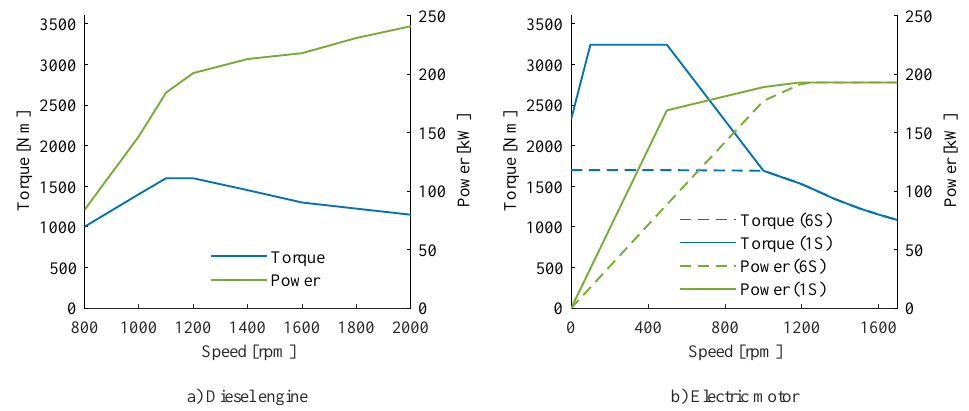
Figure 4. ( a ) Torque and power curve of the diesel engine. ( b ) Torque and power curve of the electric motor, where the both are limited according to the maximum input torque of the gearbox for the multi-speed